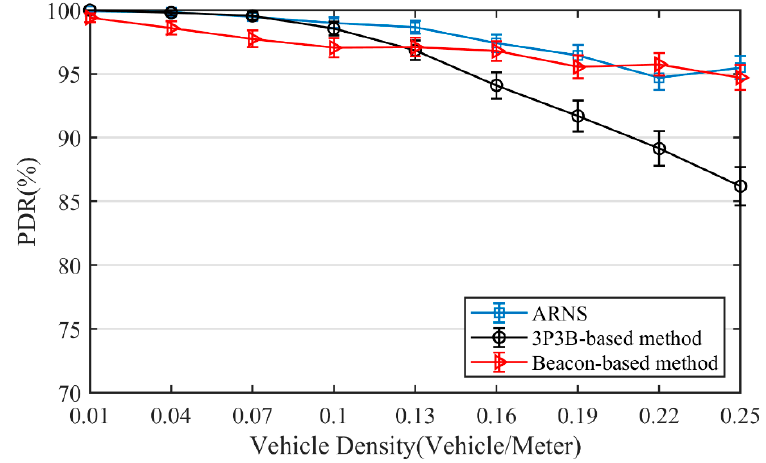
Figure 5. Maximum hops.